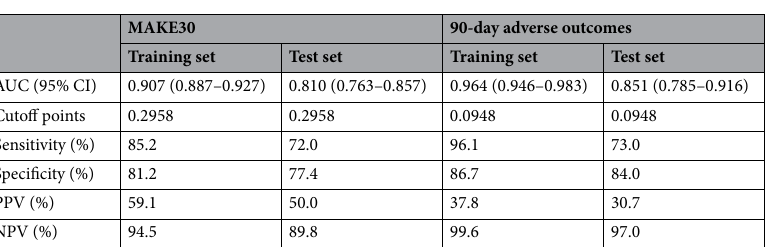
Table 5. Performance of the XGBoost models for MAKE30 and 90-day adverse outcomes in the training and test sets. MAKE30, Major Adverse Kidney Events within 30 days. AUC area under the receiver operating characteristic curve, CI confidence interval, PPV positive predictive value, NPV negative predictive